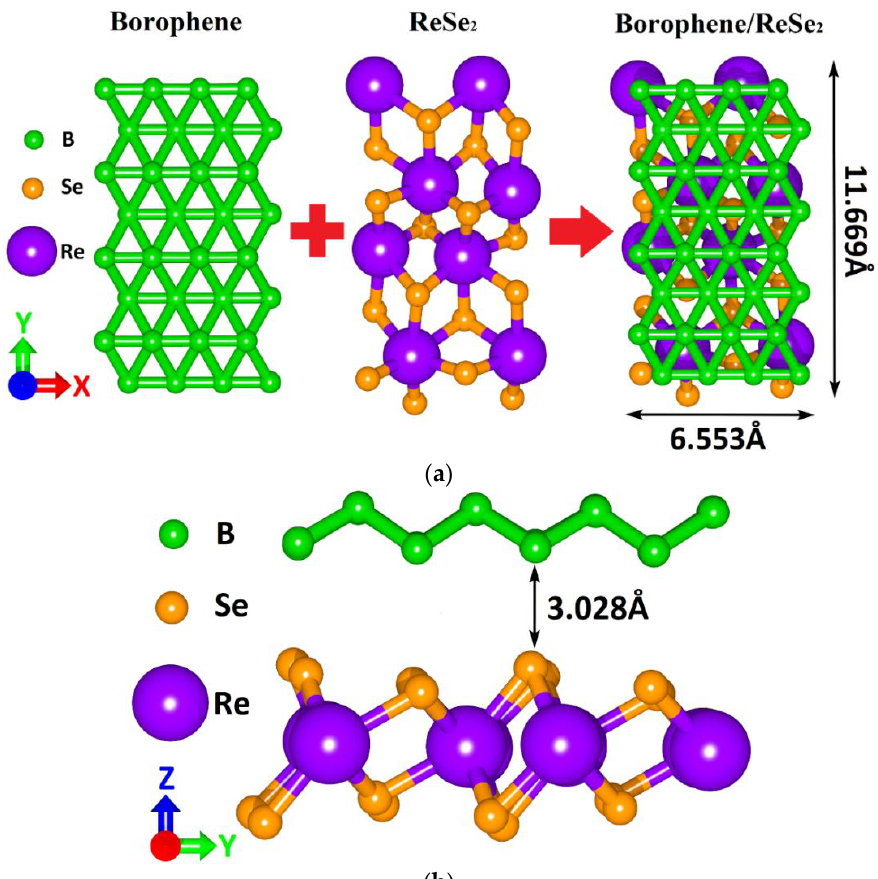
Figure 3. The process of constructing a supercell of van der Waals borophene/ReSe 2 heterostructures: ( a ) top view; ( b ) side view.